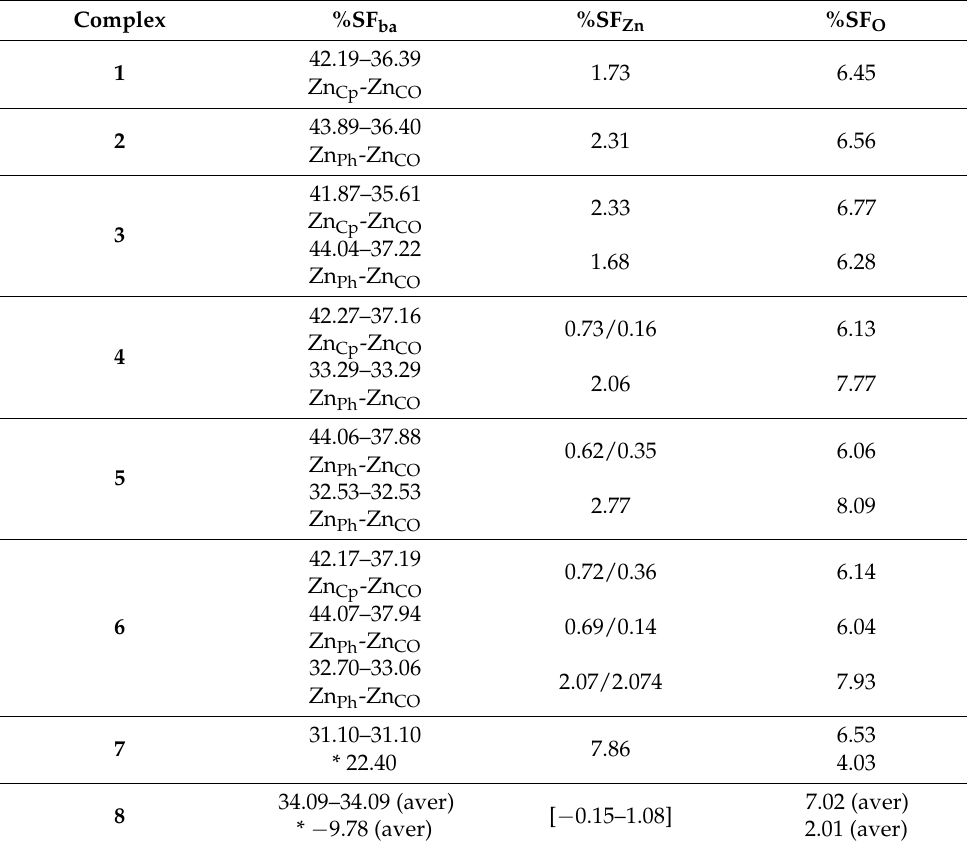
Table 5. Source Function contributions (%) to the electron density at Zn–Zn BCPs for 1 – 8 a